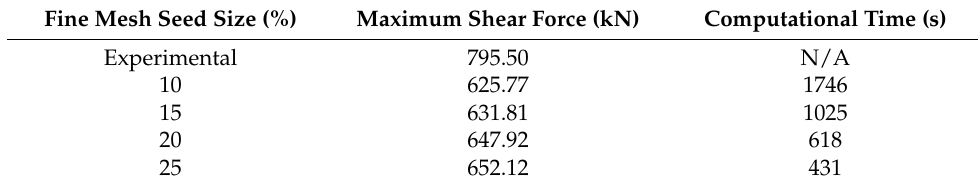
Table 10. Computational times of different fine meshes in static